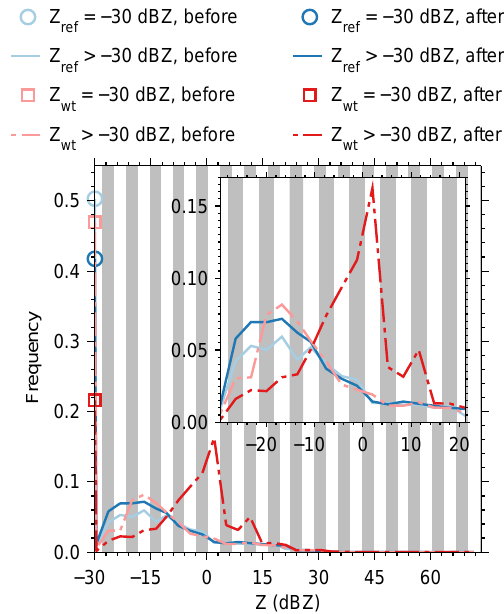
Figure 6. Relative frequency distributions of reflectivity from a ref- erence radar cell, Z ref , and from a radar cell in which three wind turbines are located, Z wt , before and after the construction of a wind farm, using data from the scan with the lowest tilt angle ( θ = 0 . 5 ◦ ). The grey and white backgrounds represent the bins that were used to create the